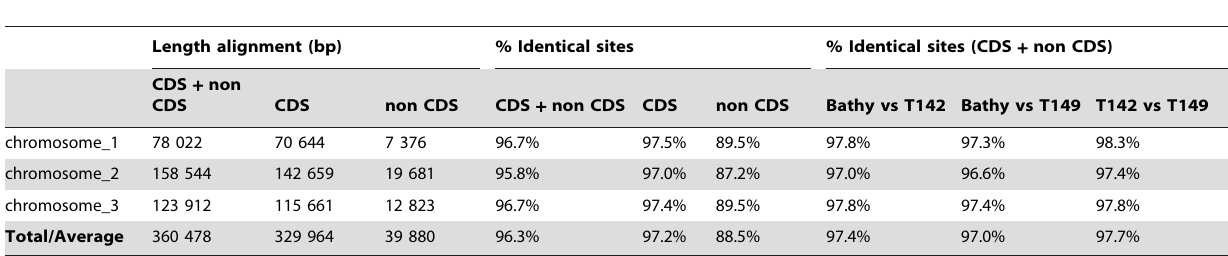
Table 3. Similarity between B. prasinos RCC1105 genome and T142 and T149 assemblies for the three larger chromosomes.